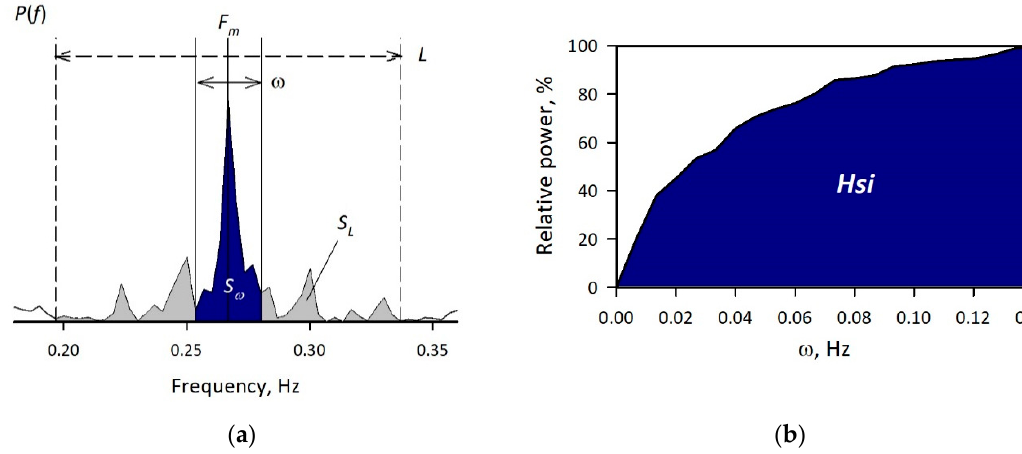
Figure 1. Computation of high frequency (HF) power concentration index, Hsi. ( a ) P ( f ) = power spectrum of biosignal. F m = frequency of the highest spectral peak in high-frequency band (0.15–0.45 Hz). S L = total power within the frequency range of F m ± L / 2 ( L = 0.14 Hz in this study). S ω = total power within the frequency range of F m ± ω / 2 (0 < ω < L ). R ω = the ratio of S ω to S L . ω = frequency rage centered at F m . ( b ) Hsi is calculated as the area under the curve (AUC) of R ω . Table 1. Characteristics of